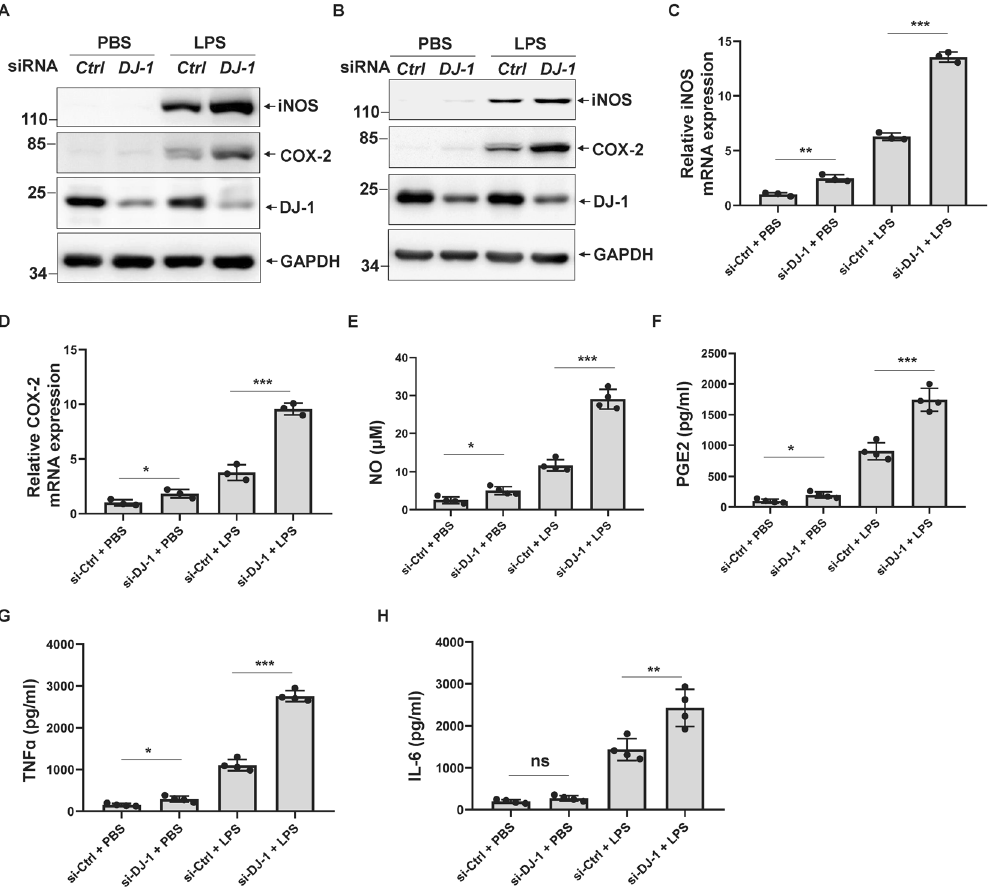
Fig. 2 DJ-1 de fi ciency results in microglia activation in vitro. A , B si- Ctrl or si- DJ-1 was transfected into primary microglia ( A ) or BV2 cells ( B ) for 48 h. The cells were then treated with PBS or LPS (100 ng/ml) for 24 h. The cell lysates were analyzed by immunoblotting using the indicated antibodies. C , D si- Ctrl or si- DJ-1 was transfected into BV2 cells for 72 h. The cells were then treated with PBS or LPS (100 ng/ml) for 6 h and then were subjected to qRT-PCR to measure C iNOS or D COX-2 mRNA levels. n = 3. E – H si- Ctrl or si- DJ-1 was transfected into BV2 cells for 48 h. The cells were then treated with PBS or LPS (100 ng/ml) for 24 h. The concentration of E NO, F PGE2, G TNF α , or H IL-6 in the cultured medium was measured. n =